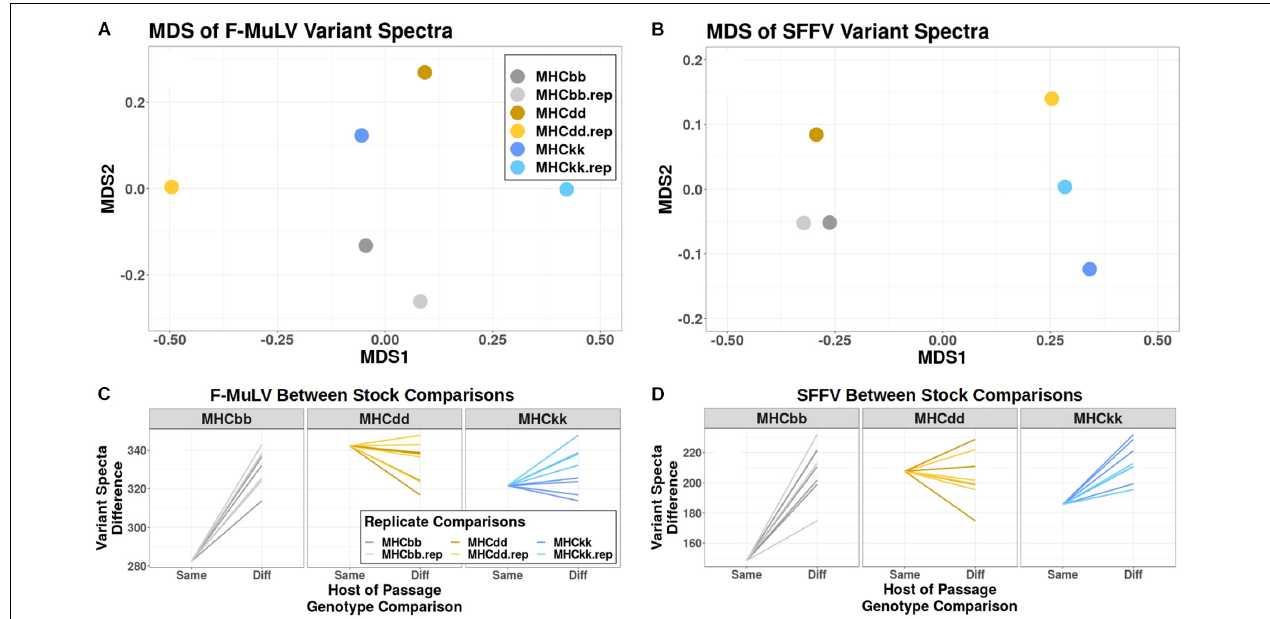
FIGURE 3 | Major histocompatibility complex specific variant spectra. (A,B) Multi-dimensional scaling plots of (A) F-MuLV and (B) SFFV variant spectra are shown. Initial distances were calculated with the Canberra method. Colors represent different host of passage MHC genotypes: Gray-MHC bb , yellow-MHC dd , and blue-MHC kk . Points from biological replicates (independent passage lines from the same host MHC genotype) are shown in lighter colors. (C,D) Comparisons of Canberra distances between variant spectra of (C) F-MuLV and (D) SFFV viral populations are shown, with the same color scheme used as panels (A,B) . The X axis denotes whether the distance reported is between stocks derived from the “Same” host genotype (i.e., MHC bb and the MHC bb replicate) or between stocks derived from different (“Diff”) host genotypes (i.e., MHC bb and MHC kk ). bb, dd, and kk show which host genotype is the reference “Same” distance. Positive slopes between “Same” and “Diff” indicate that replicates from the same host environment are more similar than replicates from alternative MHC genotypes.